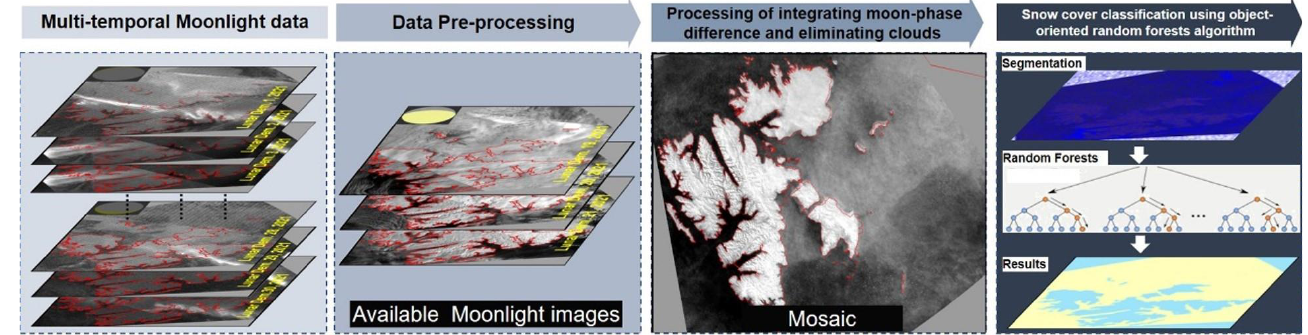
Figure 4. Flow chart of moonlight remote sensing images for monitoring snow/ice cover.